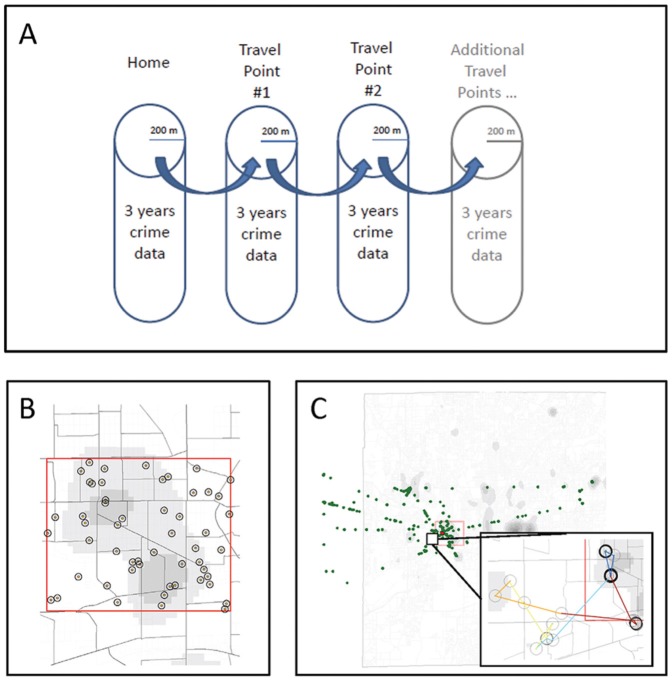
Methodology and measurement of areas of crime prevalence.(A) Conceptual depiction of path pattern exposure data to areas of crime prevalence. Each 5 minute path point includes the 3-year crime data within a 200-meter (∼1 block) buffer of this point. (B) Location of participant homes (yellow) and 200-meter buffers (black) within the study recruitment area (red) with background levels of crime ‘hot-spots’ (grey shading) and Census block groups (grey lines). (C) Path points of 1 participant (green) within and outside of the study area (red) with the inset indicating a zoomed area of path with points linked using color coding (red in the morning to blue in the evening), 200-meter buffers (black) and crime hot-spots (grey shading) and Census block groups (grey lines).